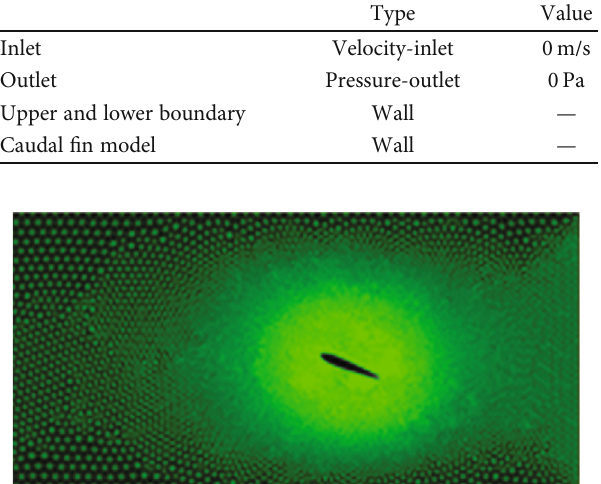
Figure 3: Finite element model.